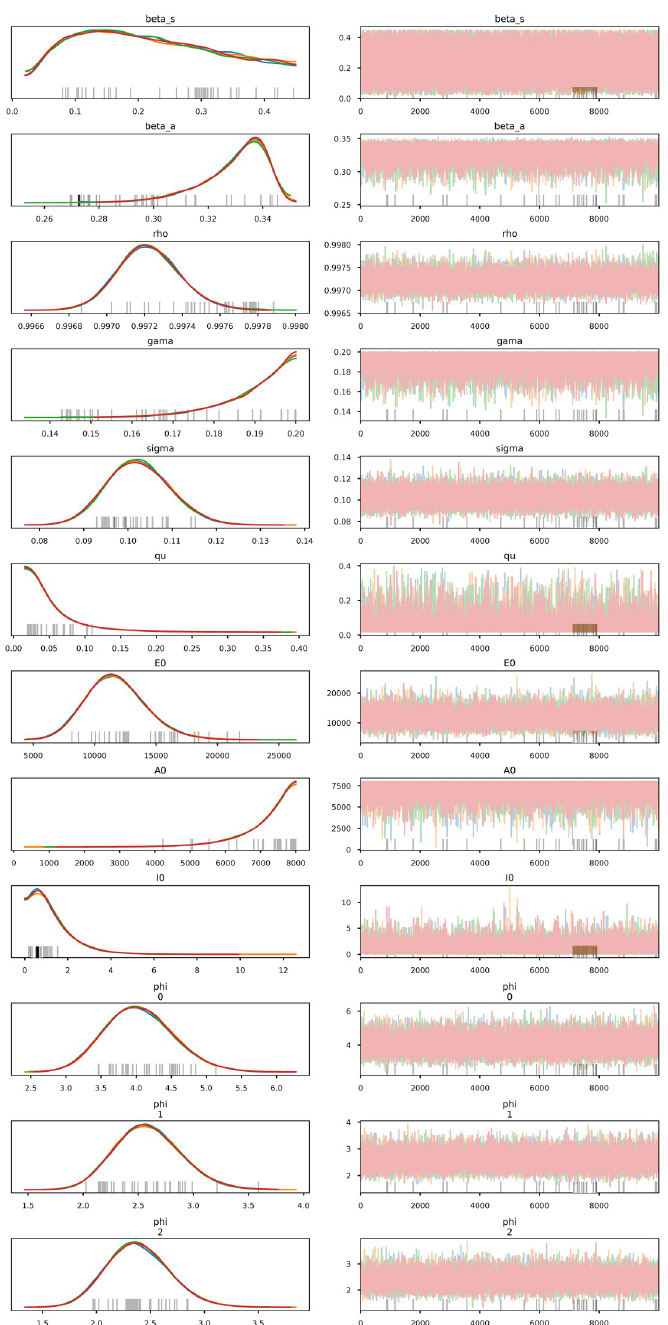
Fig 1. Credible intervals of parameters of model (1). Credible intervals within 95% Highest-Posterior Density (HPD). 97.5%. I perform 20000 iterations, with 10000 of them as a burn-in. I have used the interface in Python (PyStan). I have used the Hamilton Monte Carlo and No-U-Turn Sampler (NUTS) algorithms, obtaining similar performance. I point out that using Automatic Differentiation Variational Inference (ADVI) is much faster than the previously mentioned algorithms, with